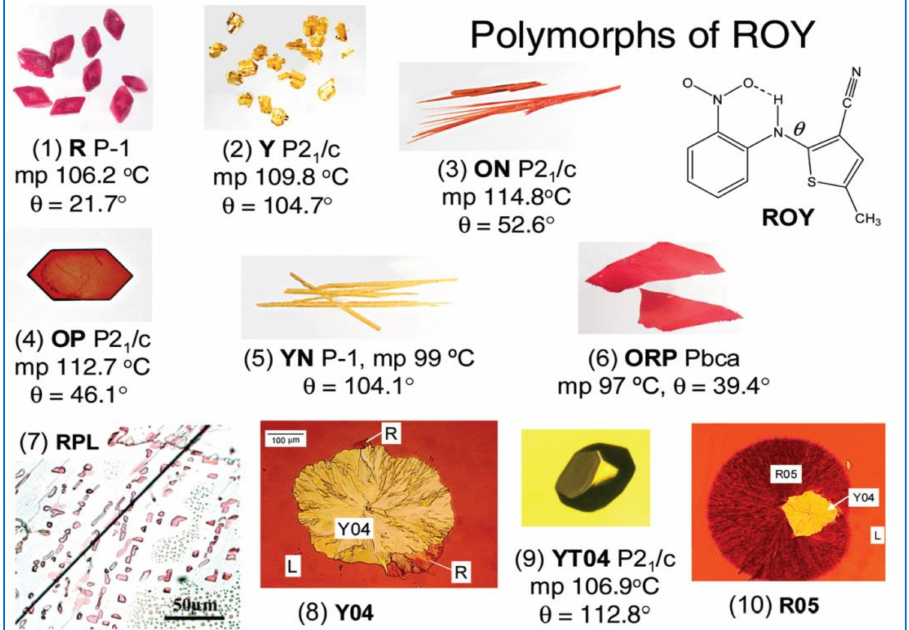
Figure 1. Differences in shape and color between the first ten (out of 13) discovered polymorphs of ROY (ROY = red, orange, yellow polymorphs of 5-methyl-2-[(2-nitrophenyl) amino]-3-thiophene carbonitrile). Reprinted with permission from Ref. [21]. 2010, American Chemical